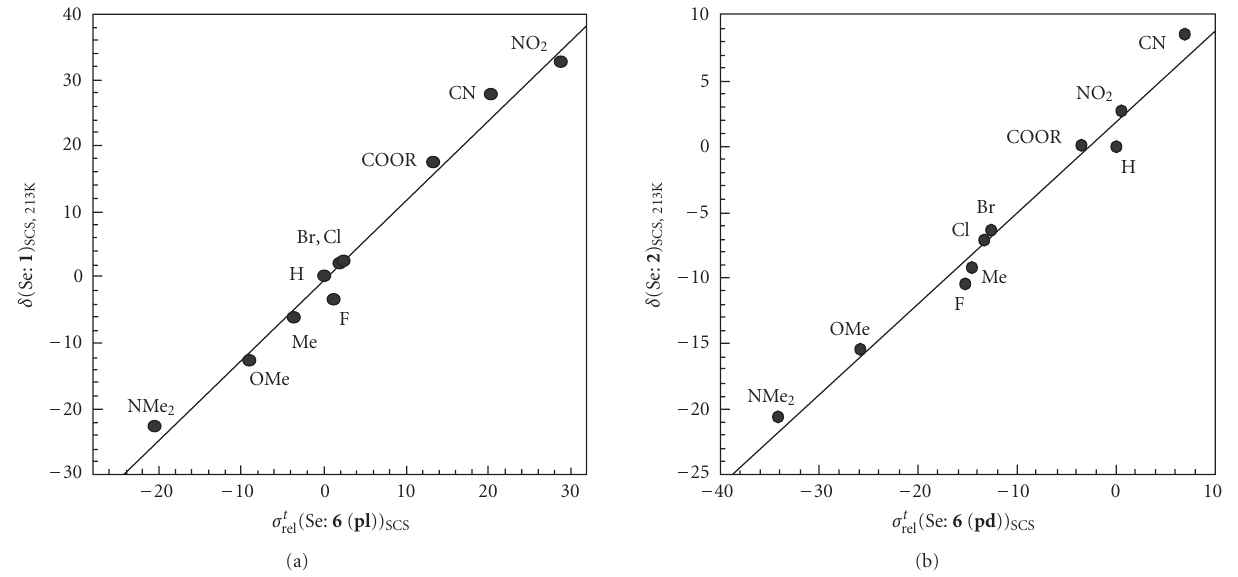
Figure 2: Plots of (a) δ (Se: 1 ) SCS, 213K versus σ t